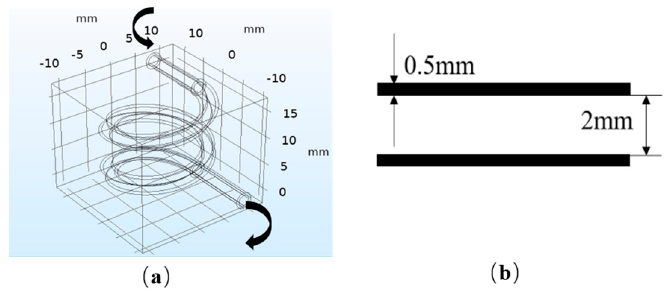
Figure 2. Fluid–structure interaction (FSI) model: ( a ) overall model; ( b ) vascular model.